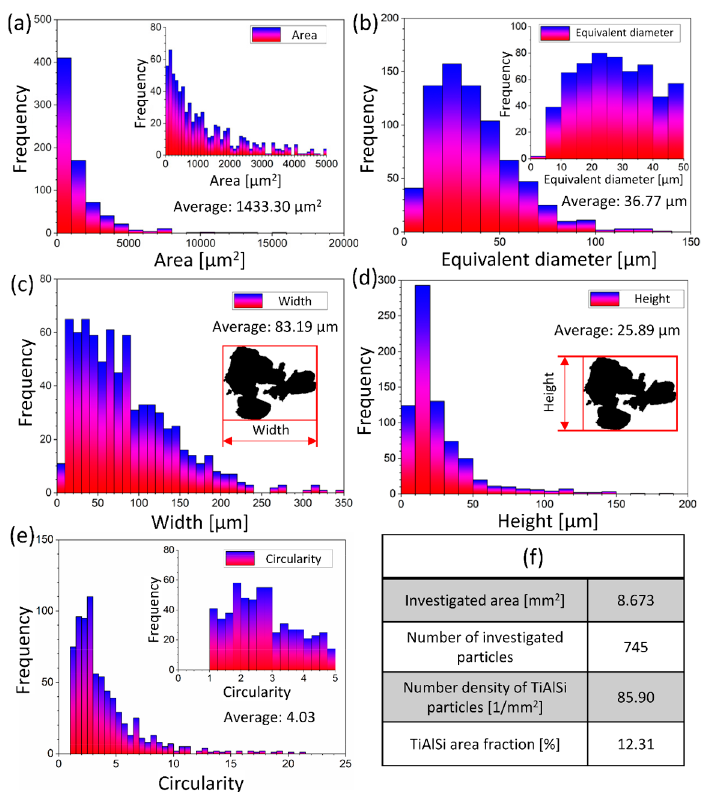
Figure A1. ( a – f ) Results of the image analysis of TiAlSi particles in the A1 sample.